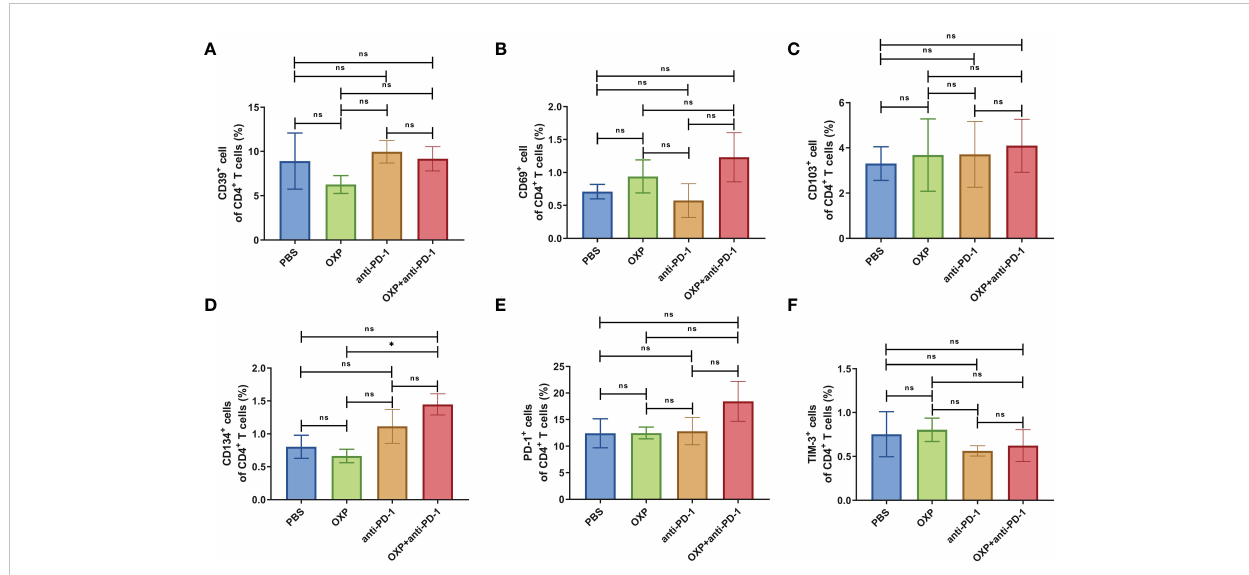
FIGURE 8 The phenotype of CD4 + T cells in PBMC. (A) The percentage of CD39 + cells of CD4 + T cells. (B) The percentage of CD69 + cells of CD4 + T cells. (C) The percentage of CD103 + cells of CD4 + T cells. (D) The percentage of CD134 + cells of CD4 + T cells. (E) The percentage of PD-1 + cells of CD4 + T cells. (F) The percentage of TIM-3 + cells of CD4 + T cells. ns P > 0.05, *P < 0.05.